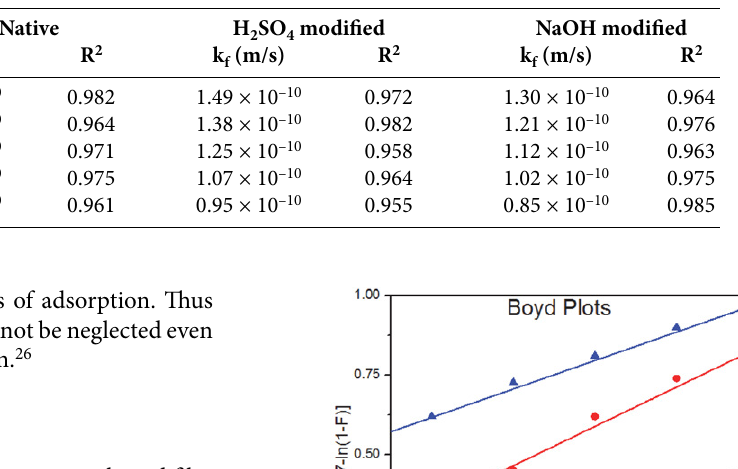
Table 3. External Diffusion Model Mass Transfer Coefficients for As(III) adsorption